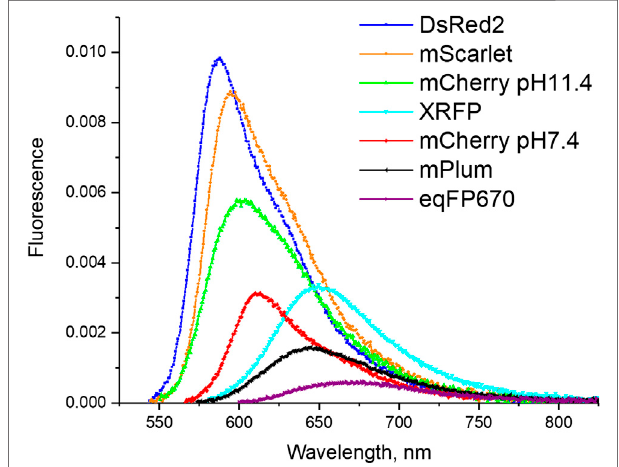
FIGURE 1 | Fluorescence spectra of a set of RFPs studied in this work. Theamplitudeofthe fl uorescenceintensityisnormalizedsuchthattheintegral under the curve is proportional to the fl uorescence quantum